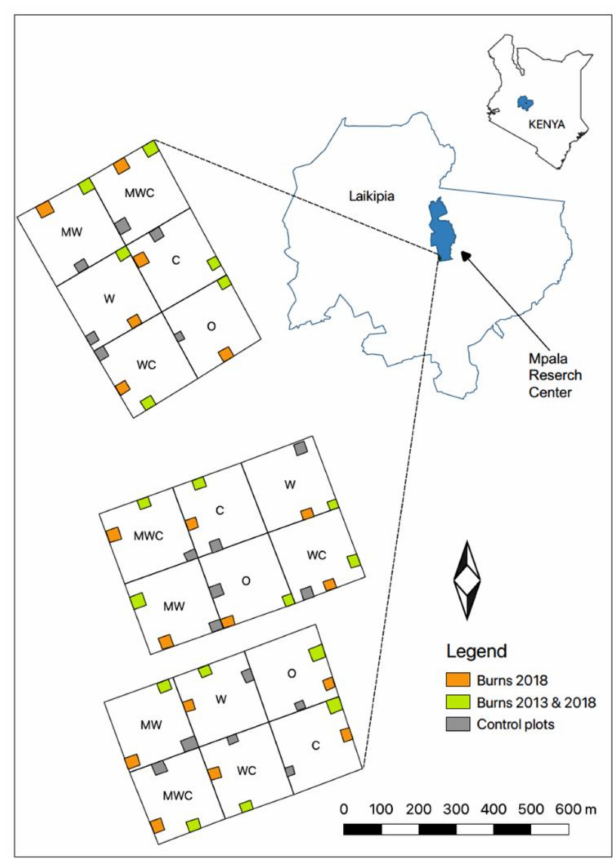
Figure 1. Layout of KLEE plots showing the locations of the burned and the control subplots. “Burns 2018” indicates subplots that were burned in 2018. “Burns 2013 & 2018” indicates subplots that were burned in 2013 and reburned in 2018. Letters denote the herbivore groups that are allowed in a particular plot; M = megaherbivores, W = wild mesoherbivores, C = cattle, O = completely fenced plots that exclude all herbivores larger than steinbucks (~15